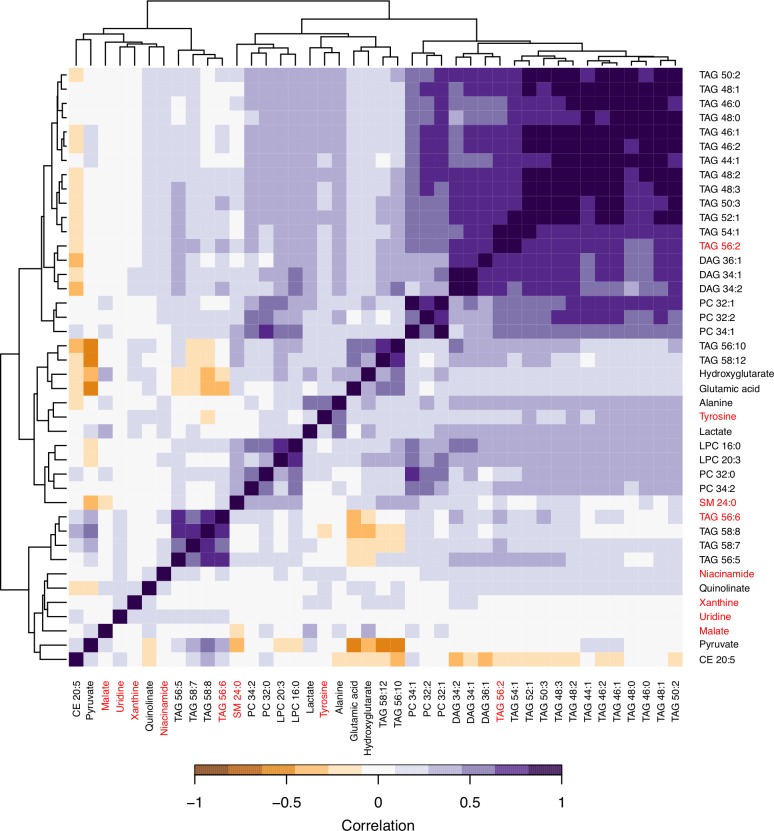
Clustered correlation heat map of the 42 ΔBMI-associated (p < 0.05) metabolites in FHS.The 8 metabolites included in the MRS are labeled in red. TAG, triacylglyceride; DAG, diacylglyceride; PC, phosphatidylcholine; LPC, lysophosphatidylcholine; SM, sphingomyelin; CE, cholesteryl ester.